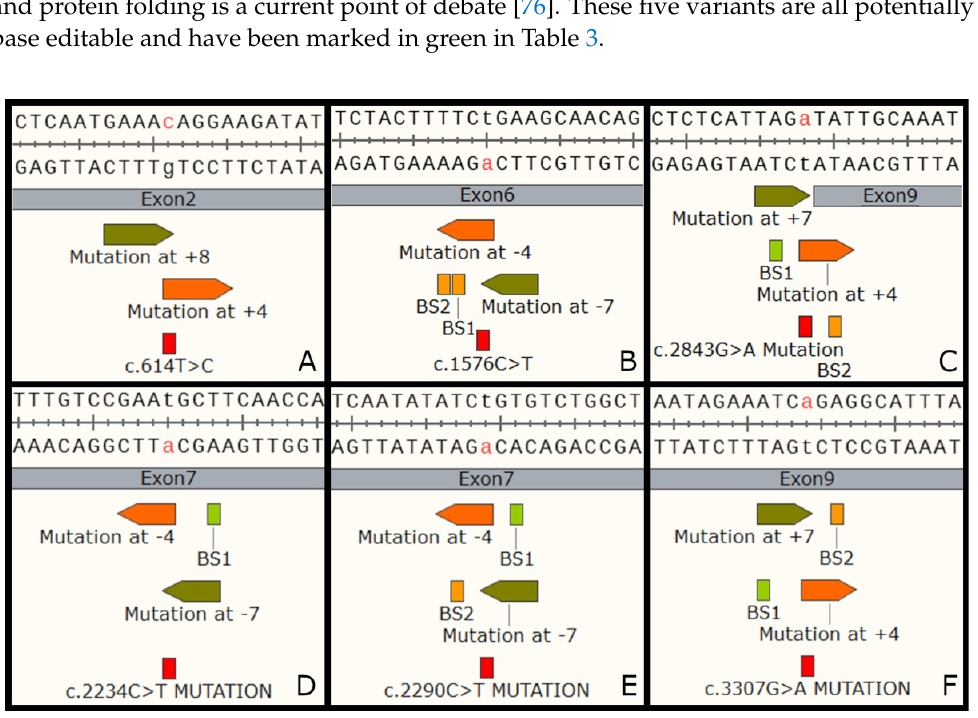
Figure 3. Base editing designs for the six trasition variants—c.614T>C ( A ), c.1576C>T ( B ), c.2843G>A ( C ), c.2234C>T ( D ), c.2290C>T ( E ), c.3307G>A ( F )—in the top 10 most frequent CRB1